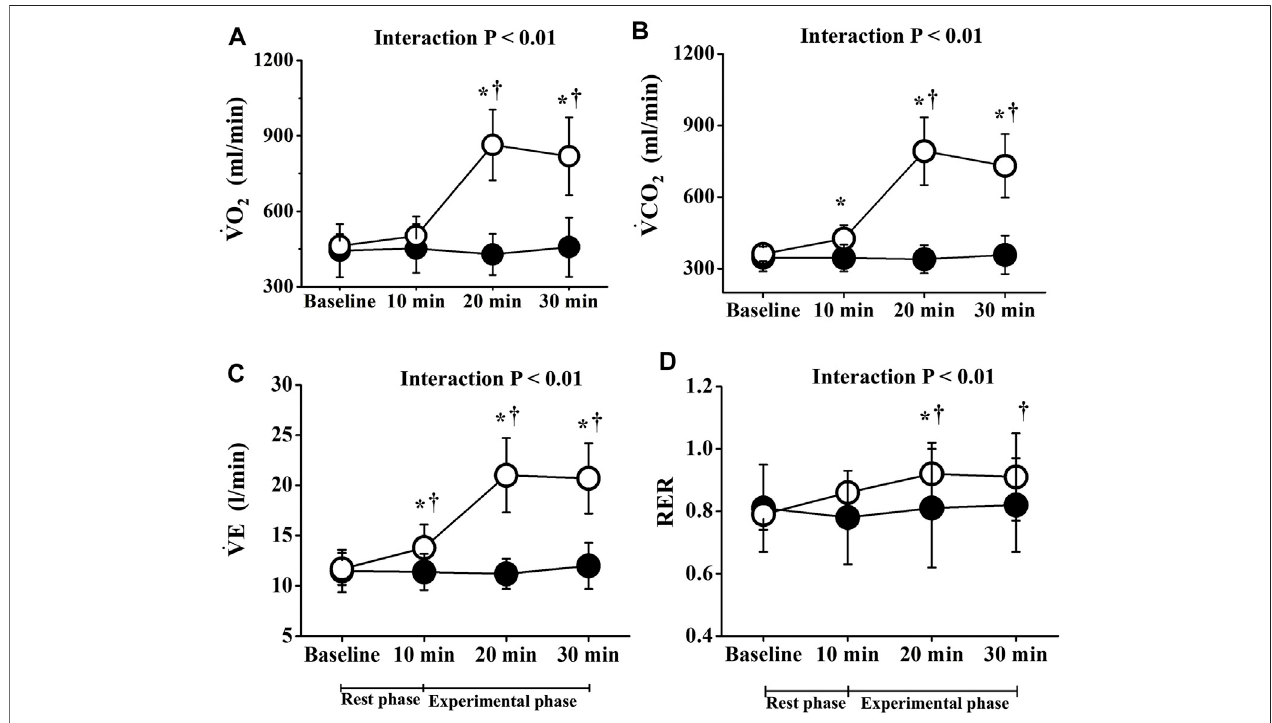
(cid:129) FIGURE 3 | Temporal changes in respiratory parameters. Filled circles ( ), control resting trial; open circles ( ○ ), electrical stimulation trial; V ・ O 2 , oxygen uptake; V ・ CO 2 , carbon dioxide output; V ・ E, minute expired ventilation; RER, respiratory exchange ratio; Baseline, before each trial. Other abbreviations are the same as in Figure 1 . p p < 0.01 vs. CT; † p < 0.01 vs. baseline. Data are given as mean ± SD.